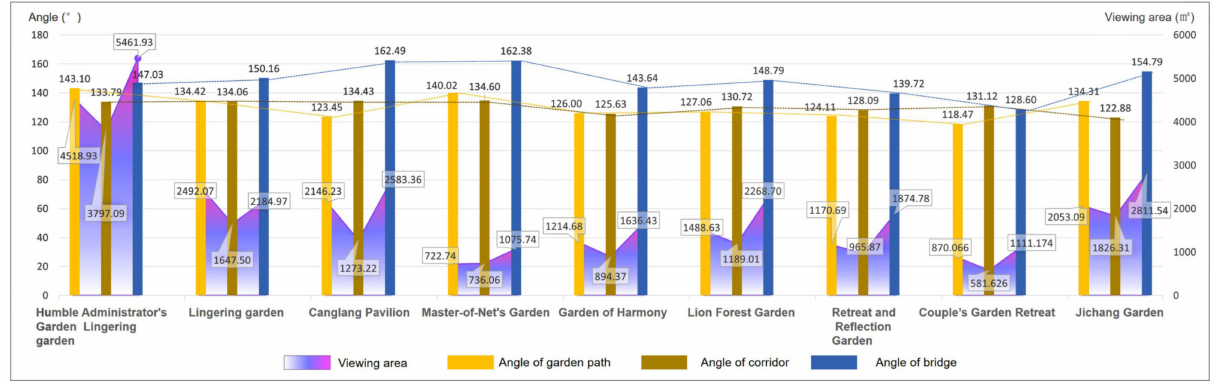
Figure 8. Average angle and average viewing area of road systems in nine Jiangnan classical